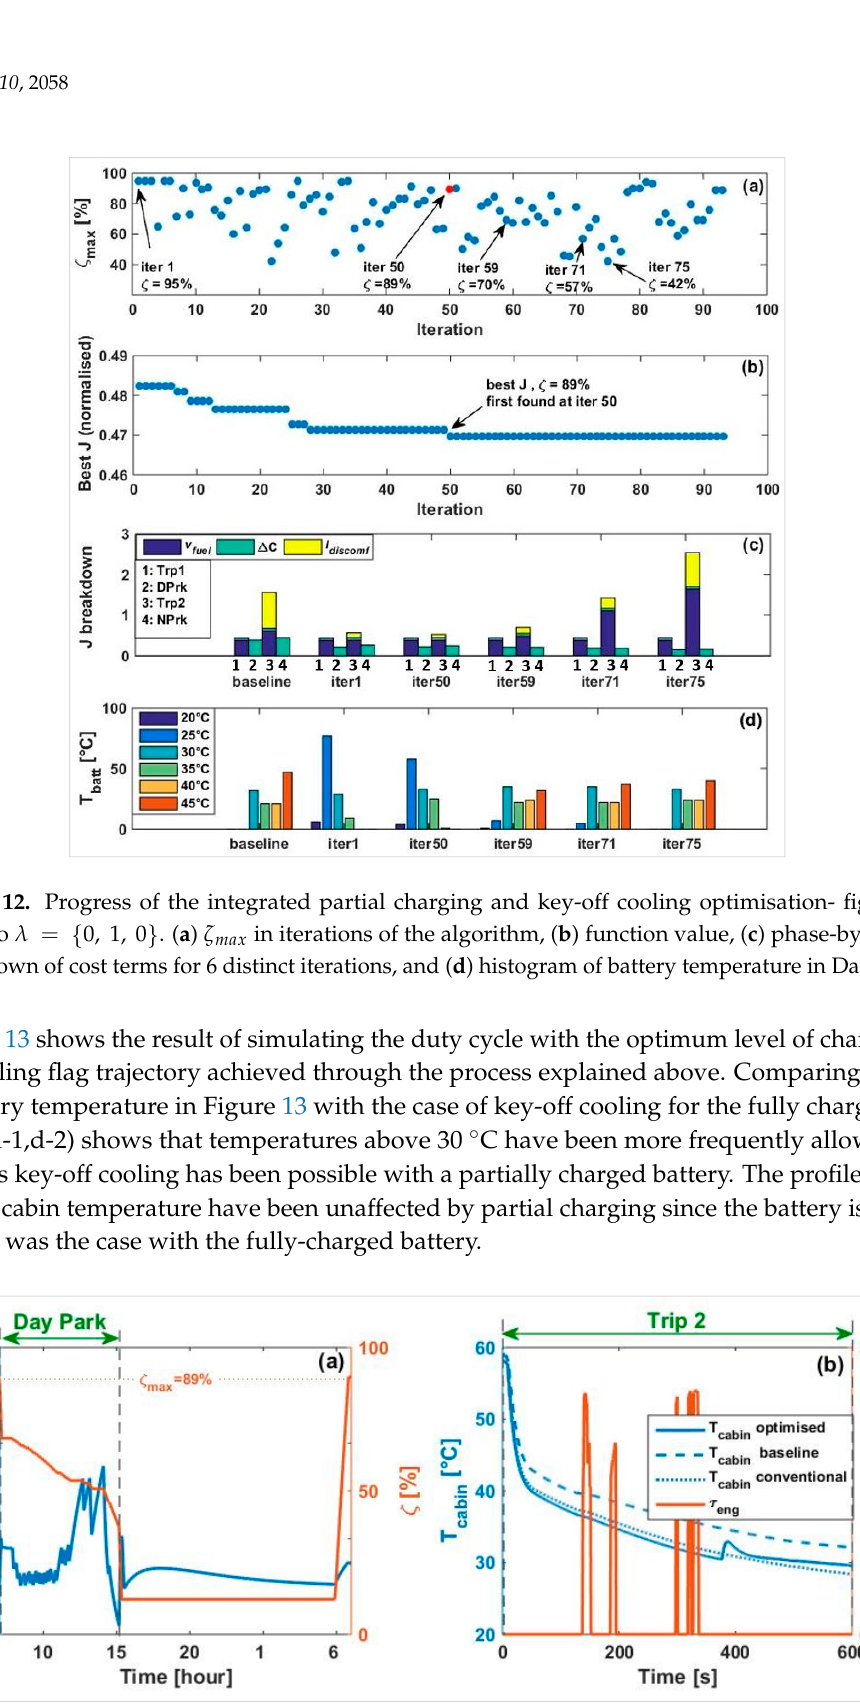
Figure 13. Result of integrated optimization of key-off cooling and partial charging. ( a ) Daily profile of battery temperature and SoC and ( b ) profiles of engine torque and cabin temperature (conventional, baseline, and optimized cases) in Trip 2.